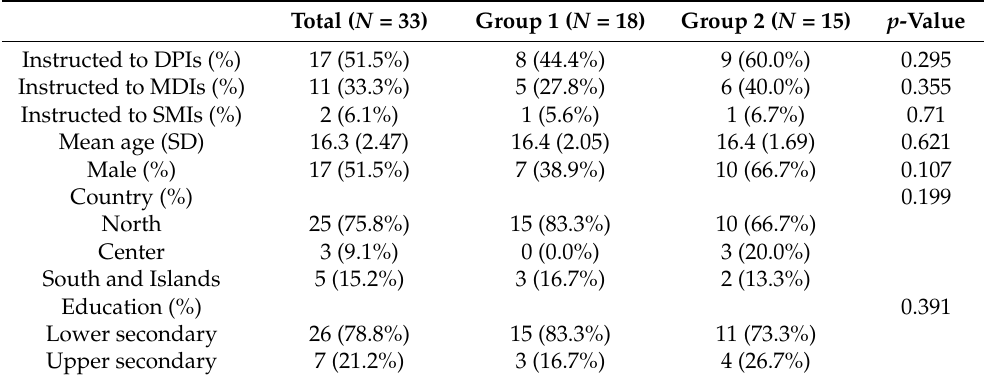
Table 1. Baseline characteristics of patients and evaluated devices using the S-GUS